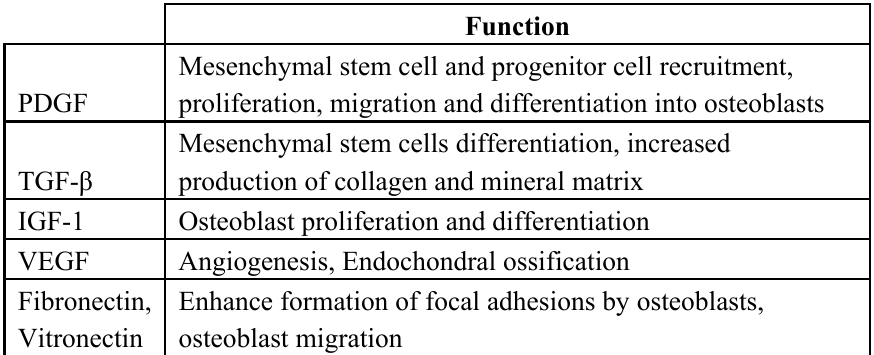
Table 1. Role of PRGF components in bone remodeling